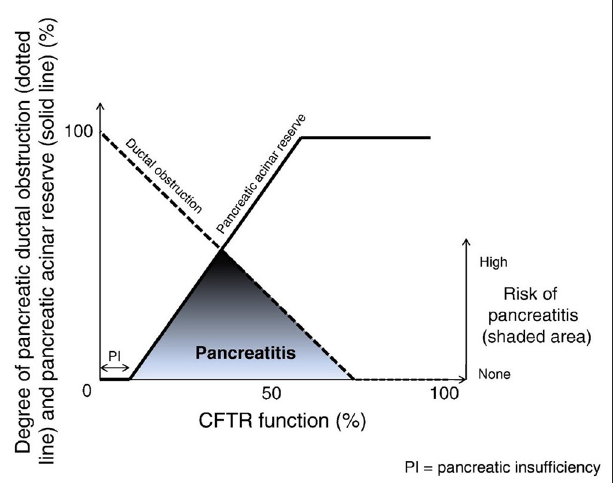
FIGURE 1 | The development of pancreatitis in the context of CFTR-related contributors. Adapted from Ooi et al. (